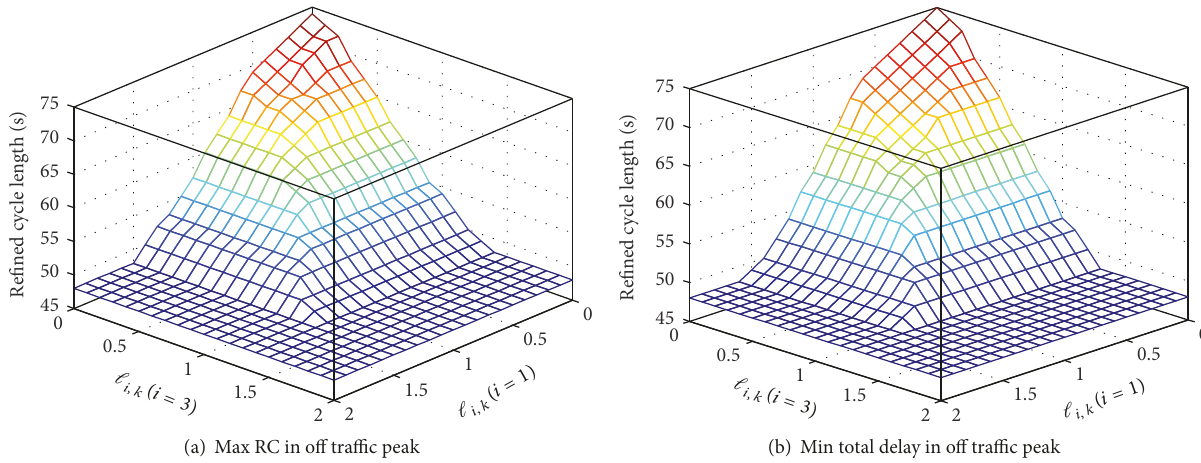
Figure 14: Combined effects of setting different initial queue lengths, ℓ 𝑖,𝑘 (𝑖 = 1, 3) , in pcu from different legs for the refinement